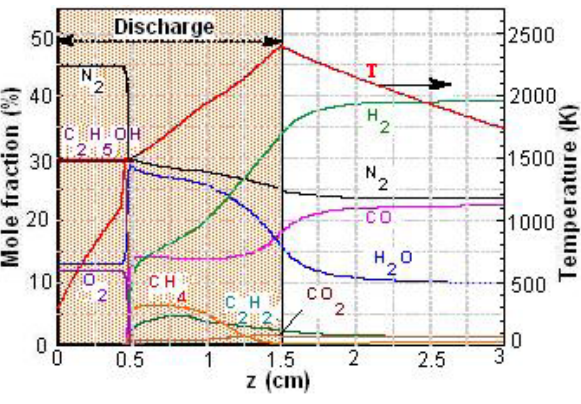
Figure 3: Equilibrium mixture composition against gas temperature.